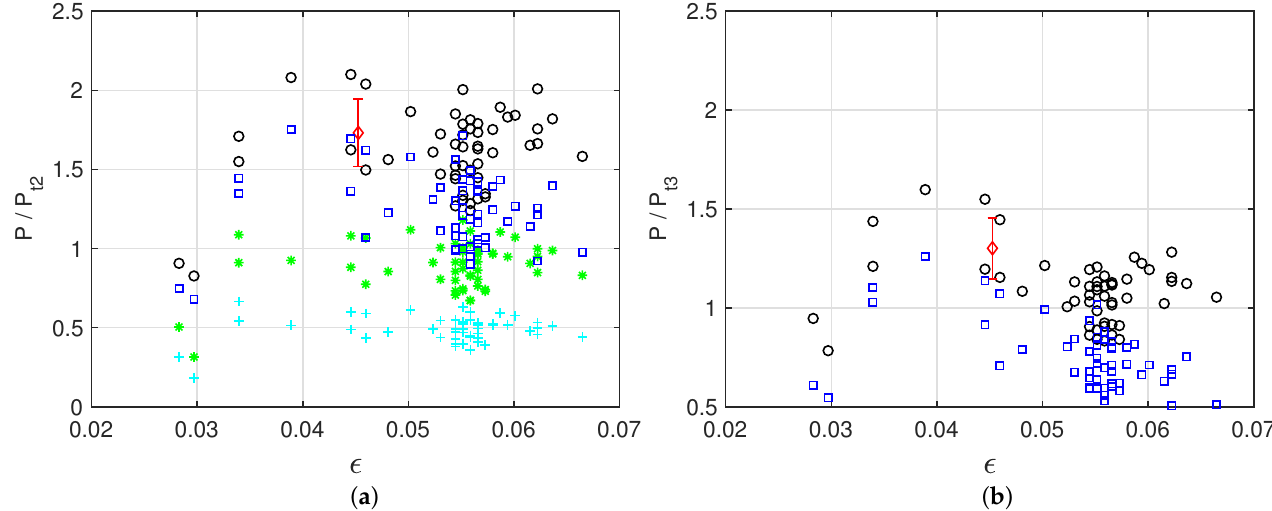
Figure 8. Probability of extreme events normalized with second-order distributions ( a ), and with the Tayfun third-order distribution P / P t 3 ( b ), as a function of wave steepness. The red diamond ( (cid:5) ) indicates case #16 (Louis Majesty accident), with error bars indicating a 95% confidence interval. Black circles ( ◦ ) correspond to P / P t 2 with µ = λ 3, HOS /3 in the Tayfun distribution. Blue squares ( (cid:3) ) correspond to P / P t 2 with µ = (cid:101) = k p σ in the Tayfun distribution. Green stars ( ∗ ) correspond to P / P t 2 with µ = k m σ ( 1 − ν + ν 2 ) in the Tayfun distribution. Cyan crosses ( + ) correspond to P / P t 2 with µ = k m σ . In panel ( b ), black circles ( ◦ ) correspond to P / P t 3 with λ 3 and λ 4 from the HOS simulation. Blue squares ( (cid:3) ) correspond to P / P t 3 with λ 3 and λ 4 estimated from µ = (cid:101) = k p σ in the Tayfun distribution.